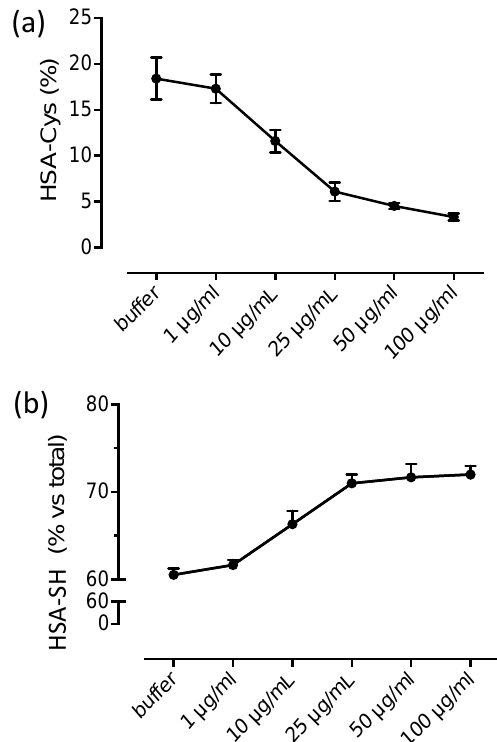
Figure 4. NAC regenerates HSA-SH in plasma of healthy donors: Dose-dependent effect of NAC in regenerating HSA-SH ( a ) by breaking the cysteinylated form ( b ) in human plasma of healthy donors.